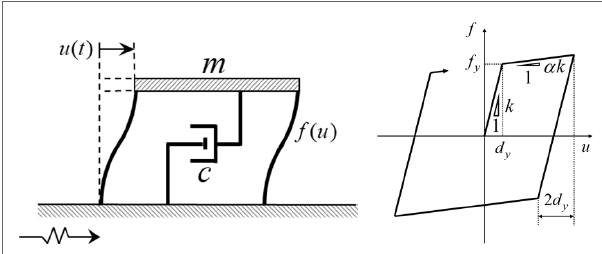
FIGURE 3 | Damped single-degree-of-freedom model and its bilinear hysteretic restoring-force